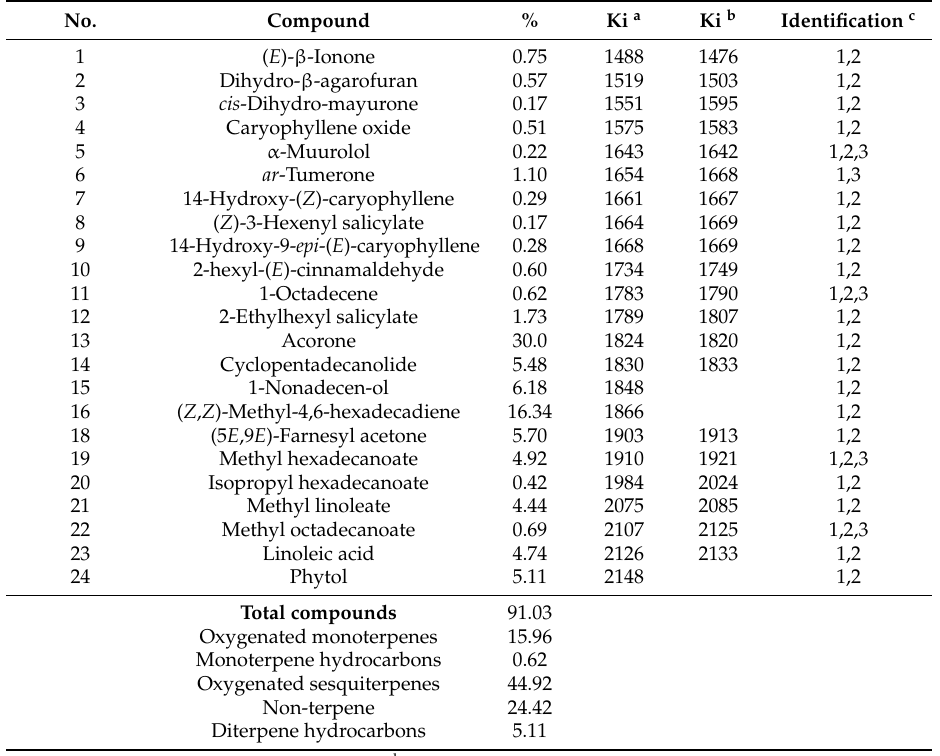
Table 1. Essential oil composition of Pereskia aculeata